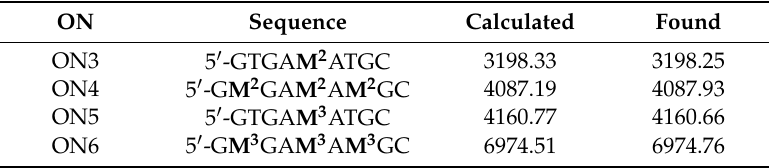
Table 4. Sequence and MALDI-MS of conjugated ON3 – ON6 . ON Sequence Calculated